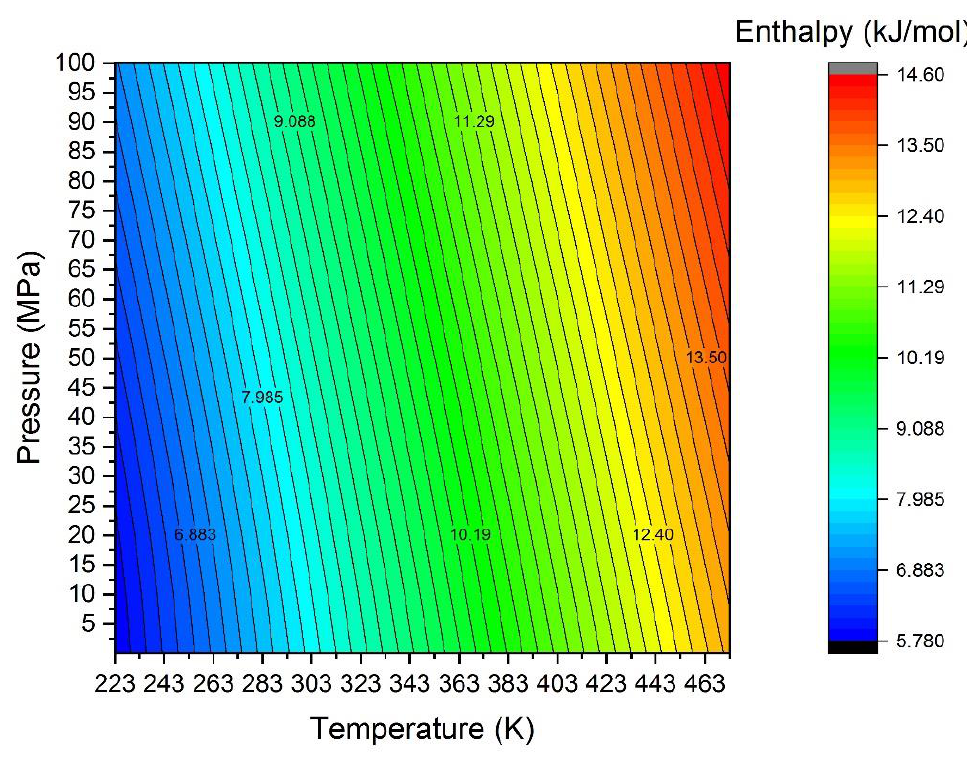
Figure 11. Enthalpy values for several pressure and temperature levels. Data processed from [40].